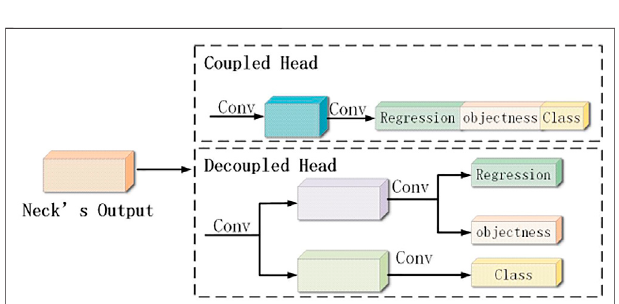
FIGURE 5 | Comparison between the decoupled head and the coupled